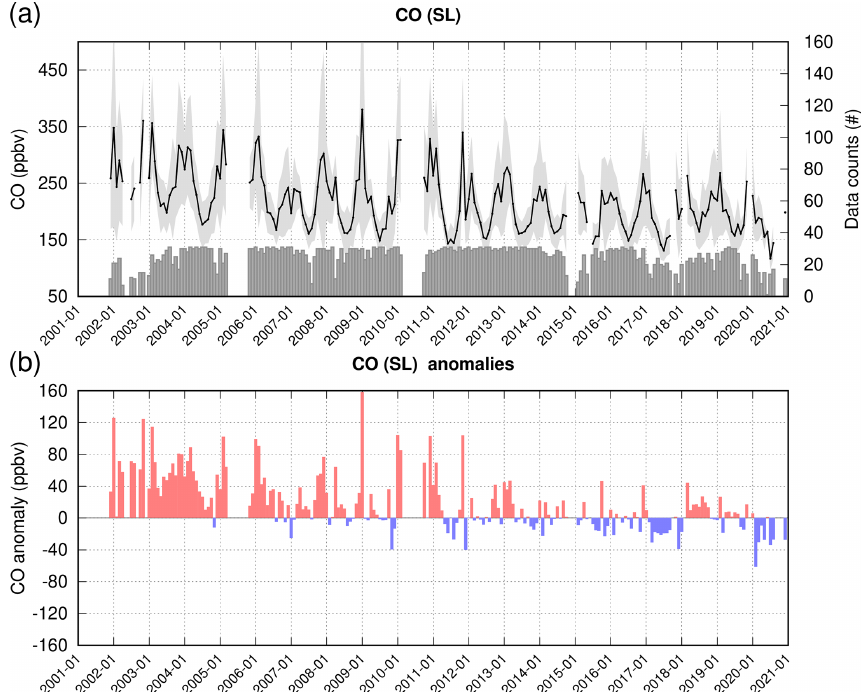
Figure 9. Monthly time series for 2001–2020 of CO for the surface layer over Frankfurt (a) . The grey bars represent the number of daily profiles used to calculate the monthly means shown in black. Grey shading represents the standard deviation for each month. (b) The monthly anomalies calculated with respect to the reference average of 2016–2019 in the surface layer. Please note that the date format used in this figure is yyyy-mm.